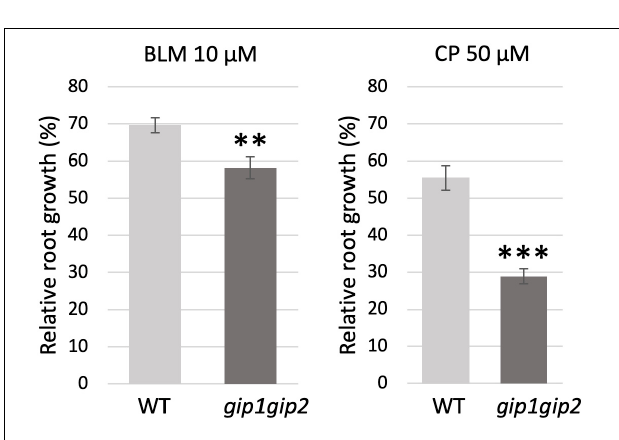
FIGURE 4 | Sensitivity of gip1gip2 toward drugs inducing DNA damage. Five-day-old seedlings grown on 1 / 2 MS media were transferred on 1 / 2 MS containing either 10 µ M bleomycin (BLM) or 50 µ M cisplatin (CP). Root growth was evaluated after 48 h on genotoxins in WT (n BLM = 16, n CP = 19) and gip1gip2 (n BLM = 20, n CP = 28) (see Supplementary Figure 1 ). Percentages of relative root growth are presented. Two independent experiments were performed. SDs are indicated. The Fisher’s exact test was performed and p -values are indicated as < 0.01 ( ∗∗ ) and < 0.001 ( ∗∗∗